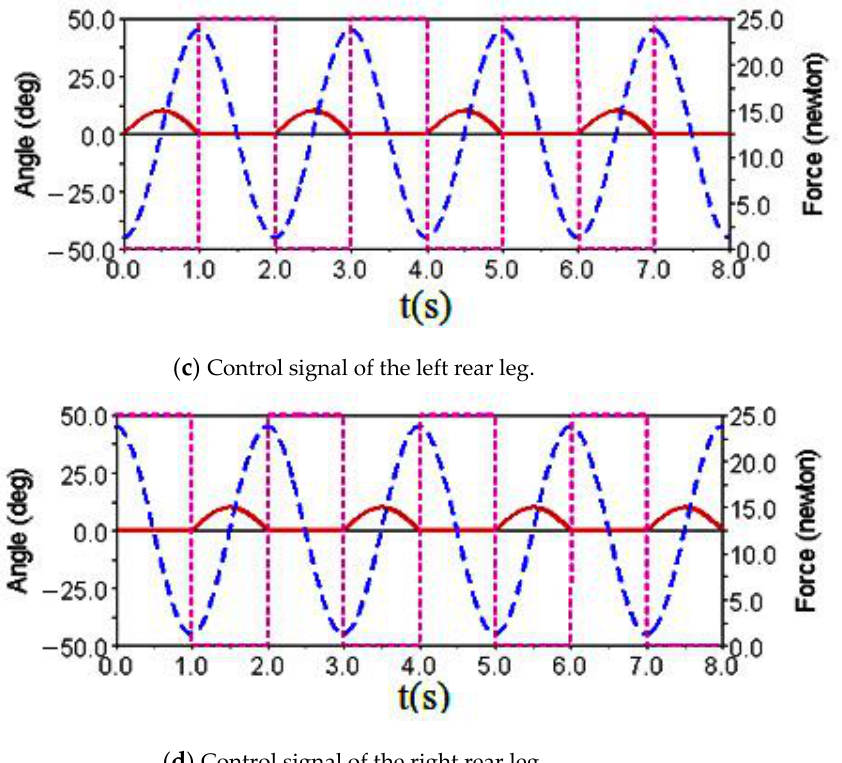
( c ) Control signal of the left rear leg.